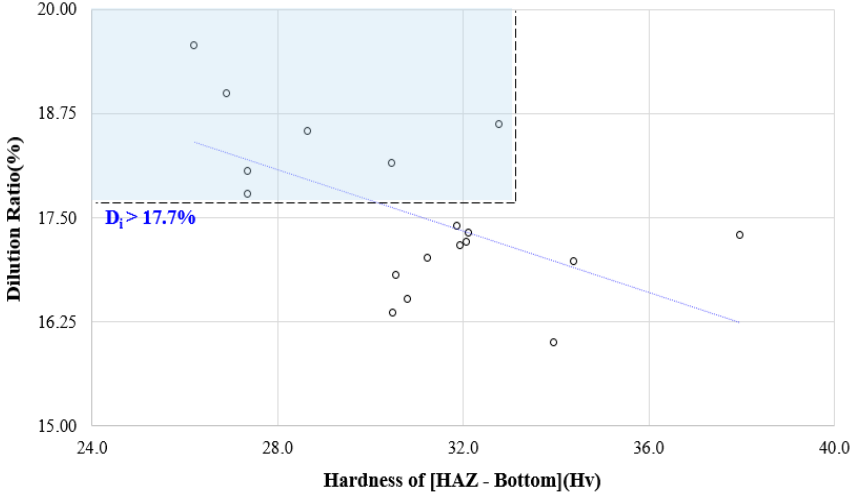
Figure 7. Weld joint hardening according to dilution ratio in fiber laser welding.